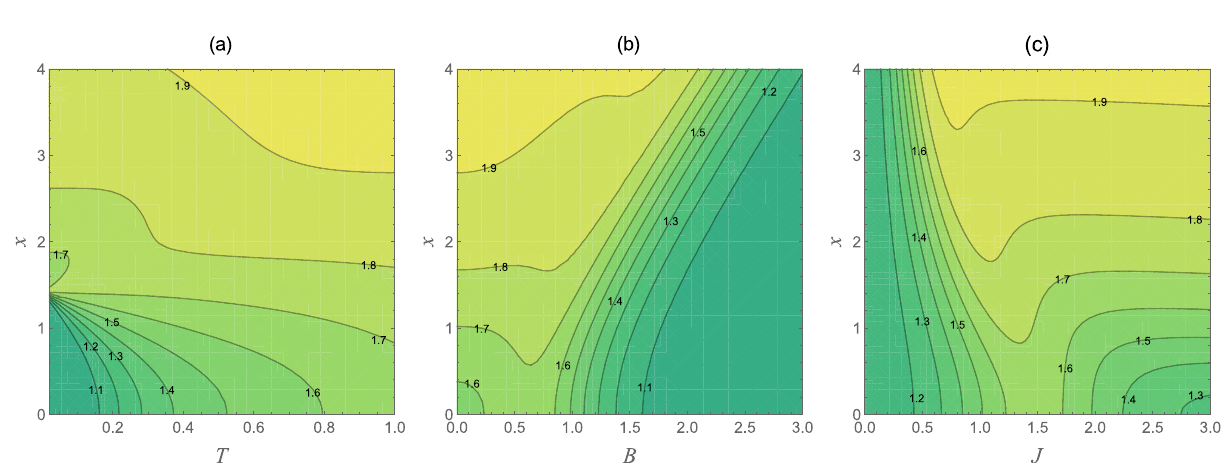
Figure 3. The entropic uncertainty bound U b (ρ T ,1 ) as a function of the inhomogeneity parameter x and different values of the temperature T , external magnetic field B , and the coupling constant J . Graph ( a ) B = 1; J = 1 , graph ( b ) T = 0.5 ; J = 1 , and graph ( c ) T = 0.5 ; B =